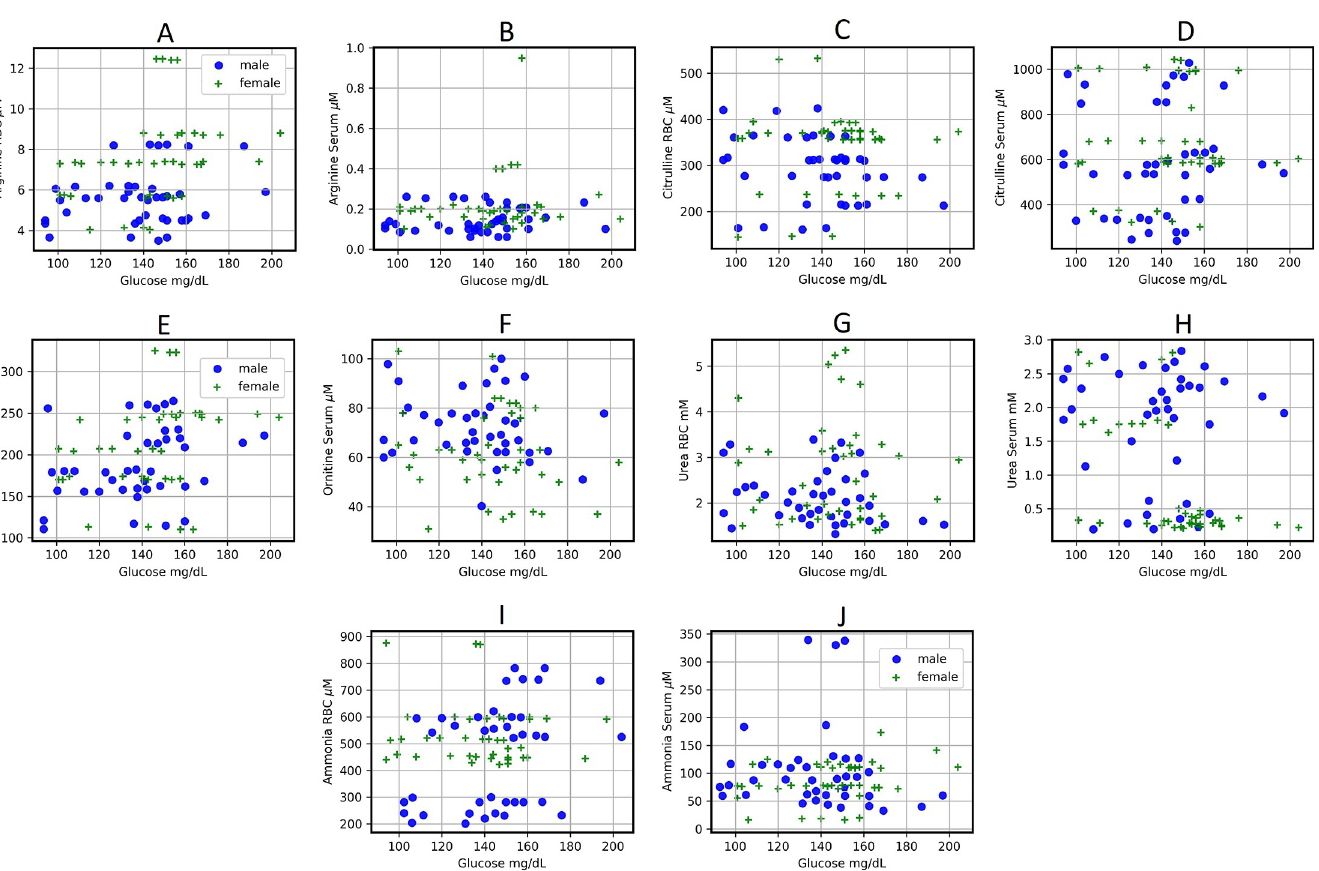
Fig 5. Scatter plots for different determinations according to gender (males are circles and females are stars) and RBC (A,C,E,G and I) or serum (B,D,F,H, and J) in DM type 2 patients. Scatter plots show the relation between two sets of data. This relation is summarized in the Spearman correlation coefficient (r) for each relation in each scatter plot:: A (rM = 0.08, rF = 0.39), B (rM = 0.14, rF = -0.014), C (rM = -0.301, rF = -0.086), D (rM = 0.113, rF = -0.044), E (rM = 0.299, rF = 0.425), F (rM = -0.133, rF = -0.163), G (rM = -0.227, rF = -0.04), H (rM = -0.013, rF = -0.559), I (rM = -0.132, rF = 0.322), and J (rM = -0.257, rF = 0.235). To see the p-values for each correlation, see the correlation matrix (S3